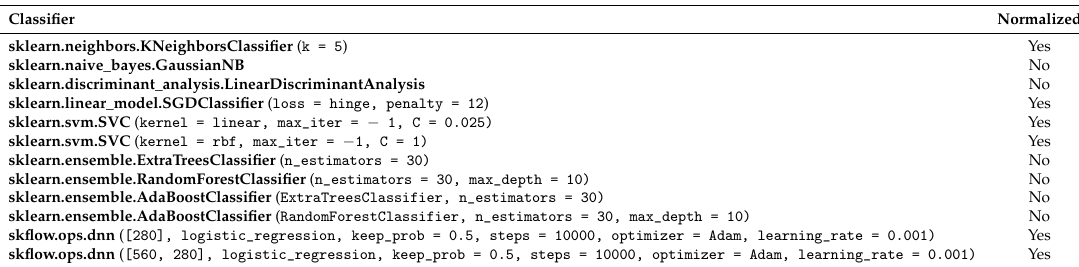
Table 4. Classifiers used in scikit-learn along with the values set for their parameters and whether data were previously normalized in the range [ 0,1 ]